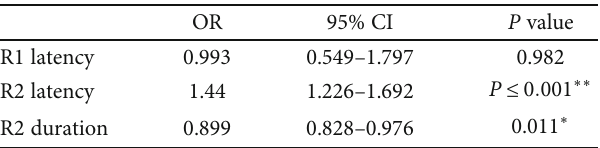
Table 6: Odds ratio for increasing risk of dizziness in binary logistic